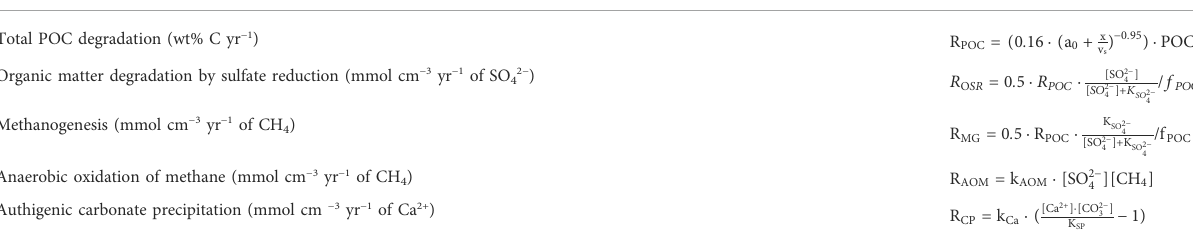
TABLE 2 Kinetic reaction rate laws in the model. Rate Kinetrc rale law a